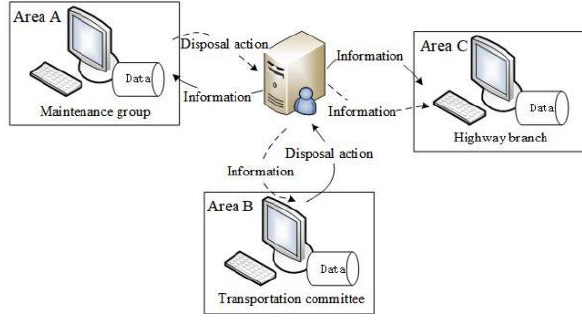
Figure 5. Cooperative operation mechanism of users